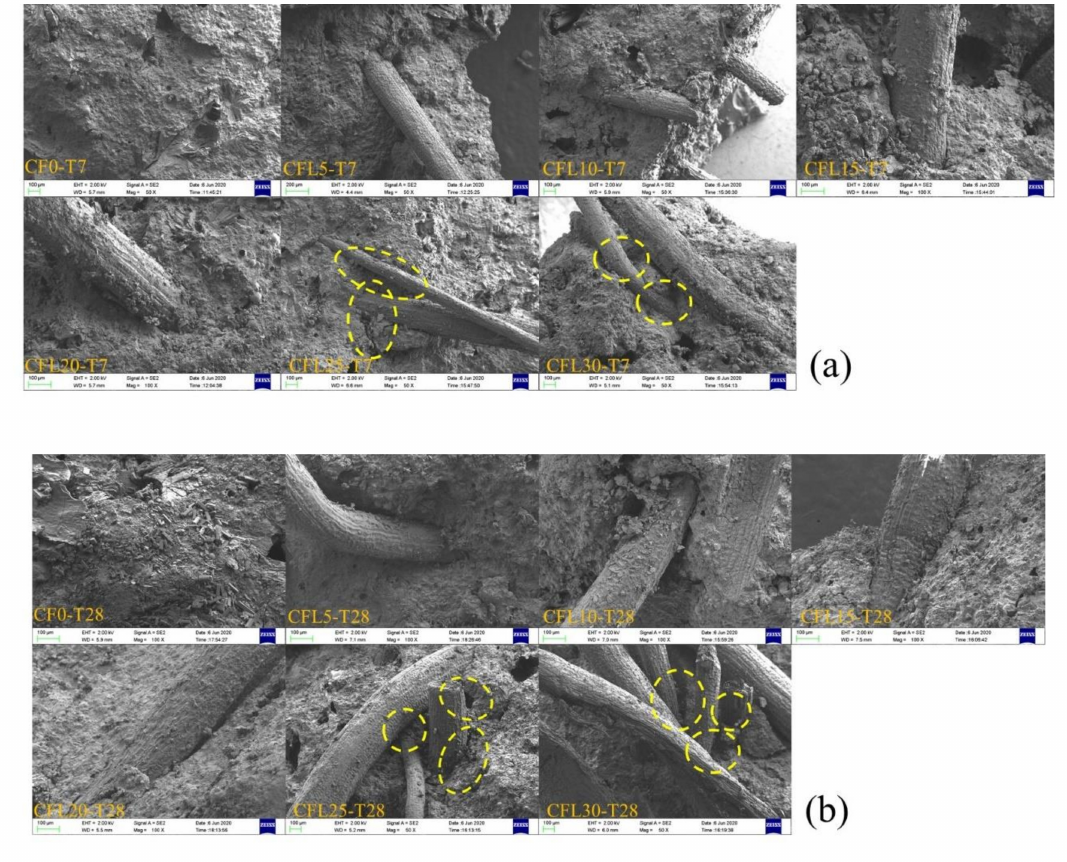
Figure 12. Scanning electron microscope (SEM) of specimens: ( a ) T7; ( b )